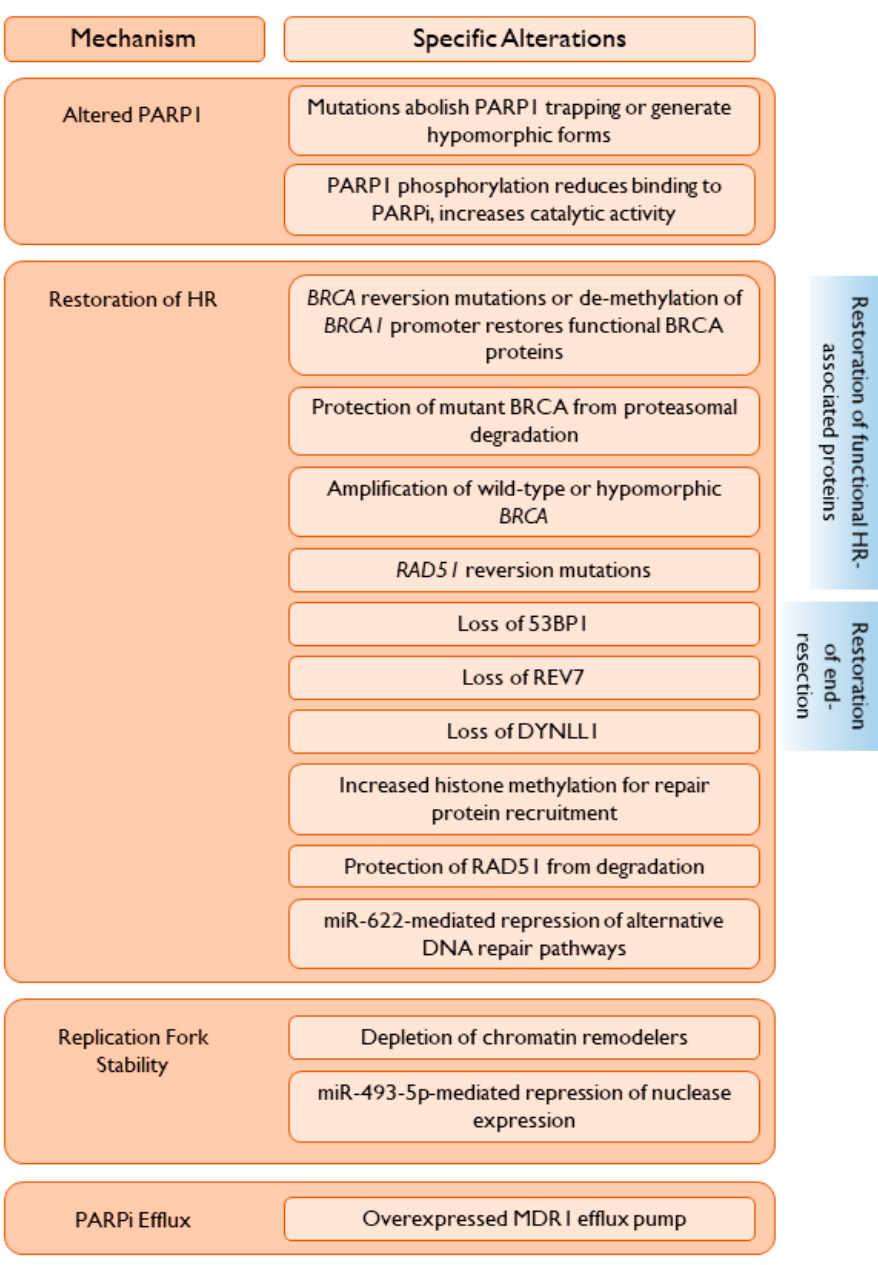
Figure 1. Thematic mechanisms of resistance to PARP inhibition.